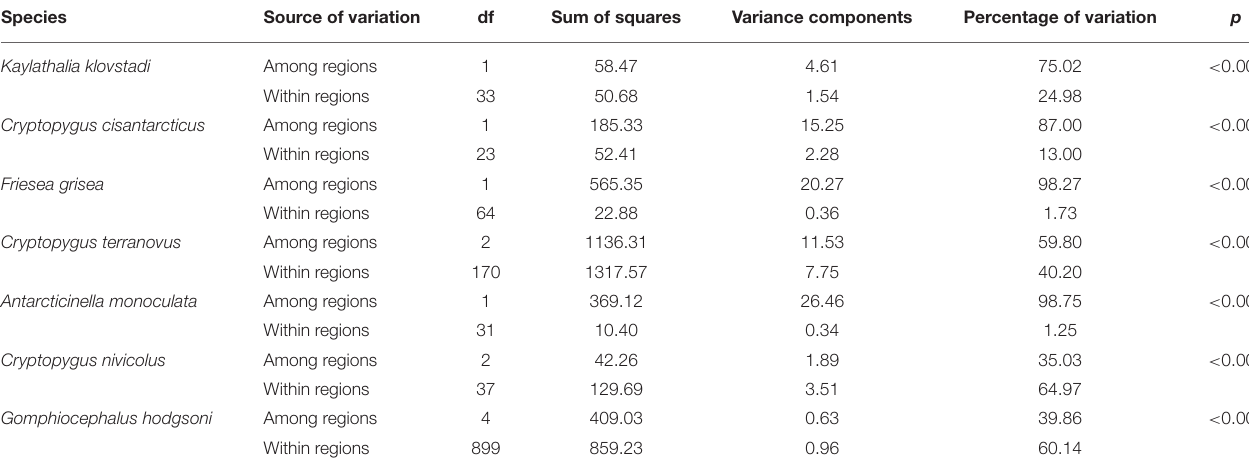
TABLE 5 | Analysis of molecular variance (AMOVA) (Excoffier et al., 1992) results for the seven species of Collembola in Victoria Land, as implemented in R v3.5.1 using the package “poppr” (Kamvar et al., 2014, 2015). Species Source of variation df Sum of squares Variance components Percentage of variation